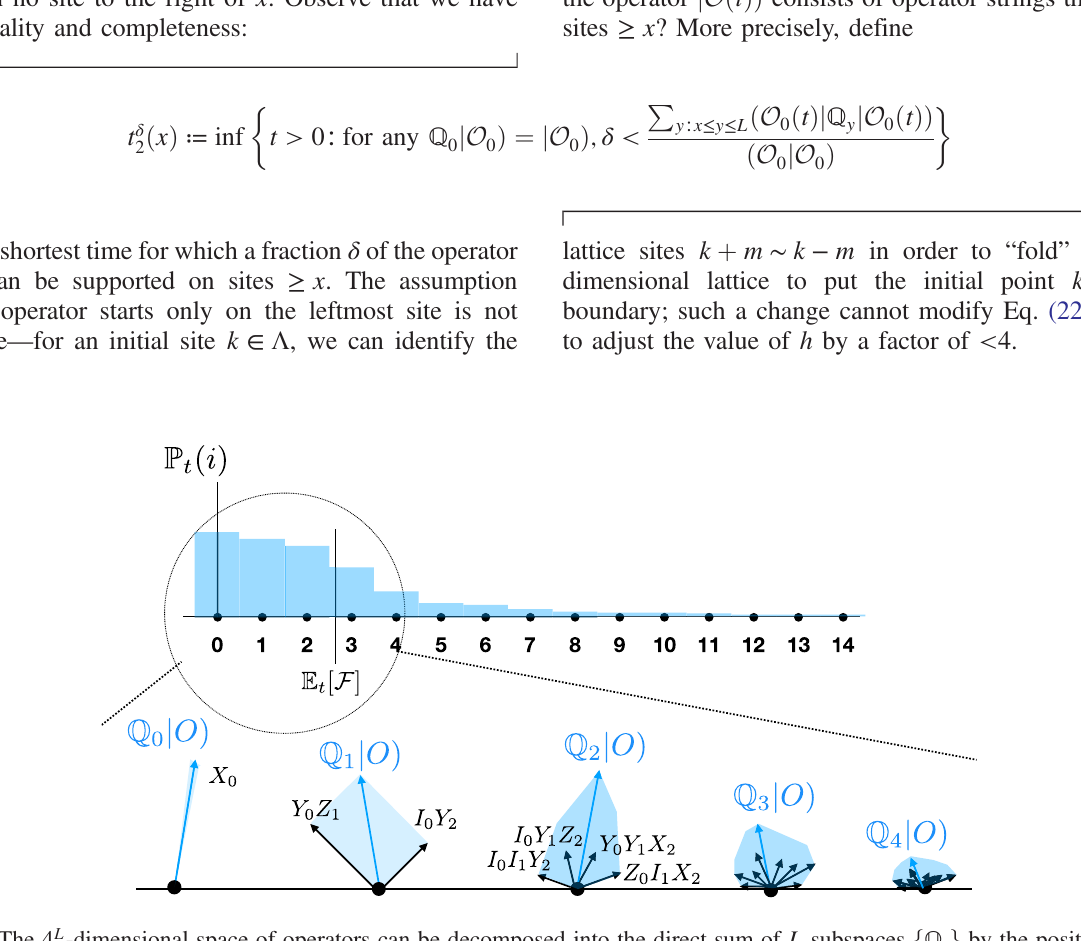
by the position of the i g